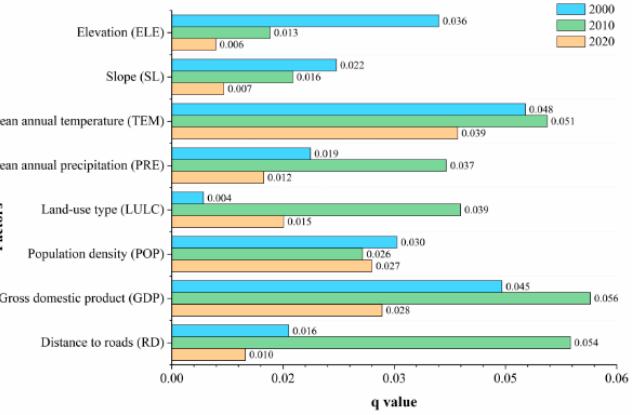
Figure 10. The q values of driving factors for the spatial differentiation of small and micro wetlands in Wuxi area from 2000 to 2020.